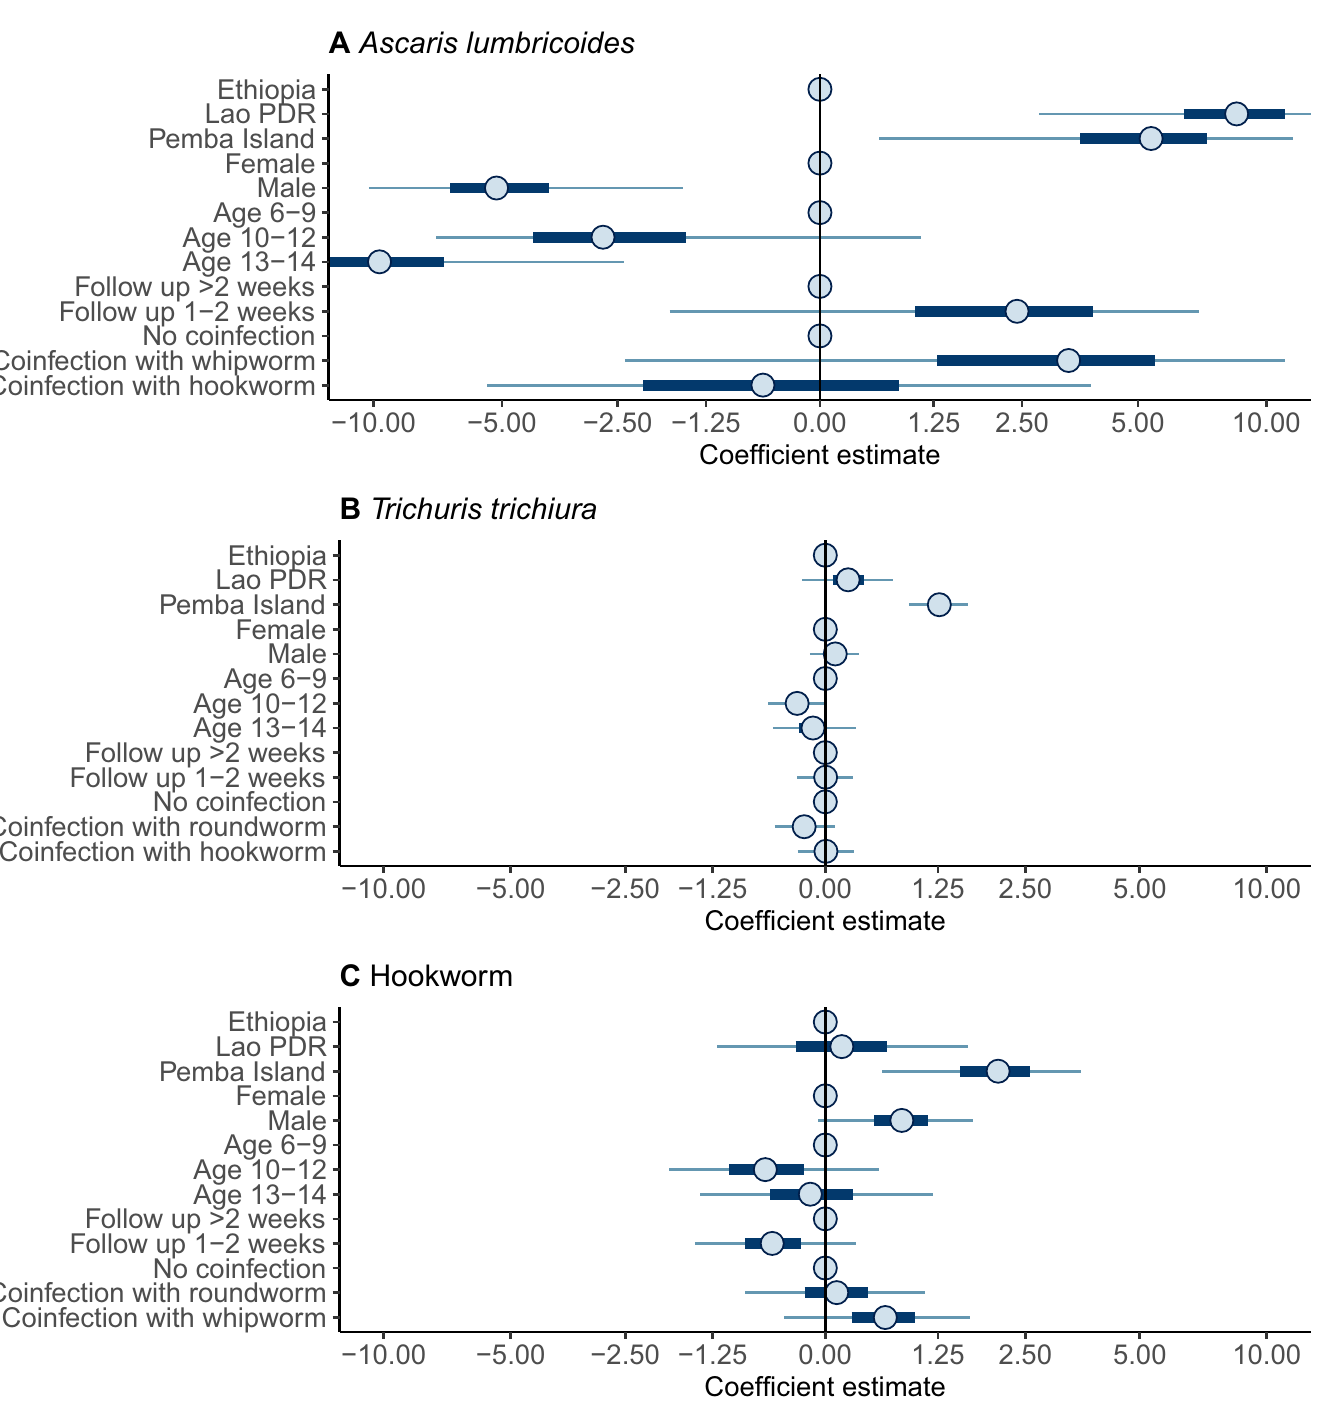
Fig 3. Coefficients of fixed effects terms associated with the efficacy of albendazole against soil-transmitted helminth infections. Coefficients were estimated by fitting the Bayesian model [15,16,21] to fecal egg count data on Ascaris lumbricoides ( panel A ), Trichuris trichiura ( panel B ) and hookworm ( panel C ) collected before and after administration of a single 400 mg oral dose of albendazole in three study sites, Ethiopia, Lao PDR and Pemba Island (Tanzania). Points, horizontal thick and thin lines indicate the median, the 50% and the 95% credible interval respectively. The reference category of each variable is indicated by a point on the vertical line (Ethiopia; female; age 6–9 years; follow up > 2 weeks and no coinfection). Positive coefficients indicate a lower individual egg reduction rate, ERR i . Negative coefficients indicate a higher